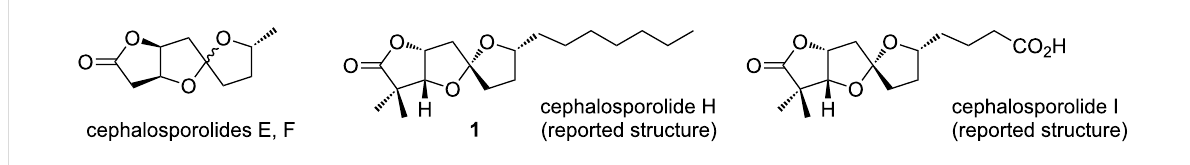
Figure 2: Spiroketal-containing cephalosporolide natural products.